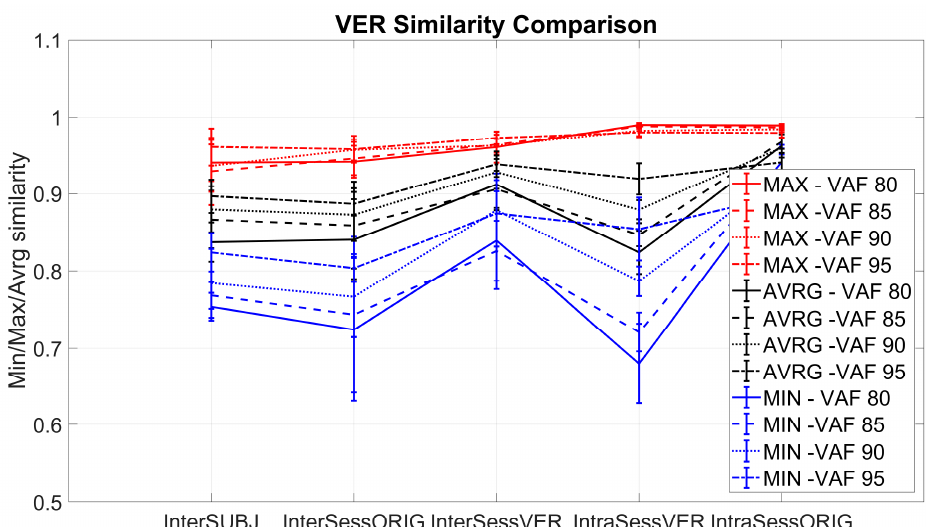
Figure 17. Comparison of muscle synergy similarity in the five considered conditions: inter-session (InterSessORIG), intra-session with sub-selection (IntraSessORIG), intra- and inter-session with virtual electrode repositioning (IntraSessVER and InterSessVER), and inter-subject (InterSUBJ) for all 10 participants and several VAF thresholds. The X axis represents several tests as described above, and the Y axis represents MIN (blue), MAX (red), or AVRG (black) values of